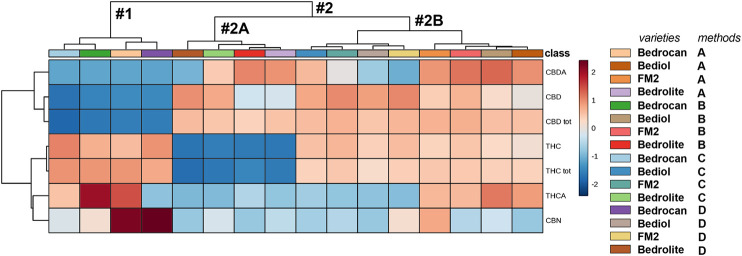
A heatmap overview (showing only group average) with hierarchical clustering of the 4,774 cannabis oils. The first cluster (#1) included Bedrocan variety and the second one (#2) the other varieties, which in particular consisted of (#2A) Bedrolite and (#2B) Bediol and FM2. In respect to other varieties, Bedrocan displayed a lower concentration of CBD (tot, neutral, and acid) and Bedrolite of THC (tot and neutral). The color-scale differentiates values as high (red), mid (gray), and low (blue). For details on preparation methods, see the following references: Method A (Romano and Hazekamp, 2013), Method B (Citti et al., 2016), Method C [Società Italiana Farmacisti Preparatori (SIFAP), 2016; Casiraghi et al., 2018], and Method D (Calvi et al., 2018).